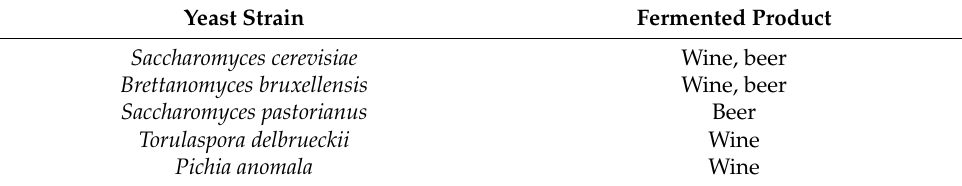
Table 3. The most common mesophilic yeasts adapted to food processing at low temperatures [143–146]. Yeast